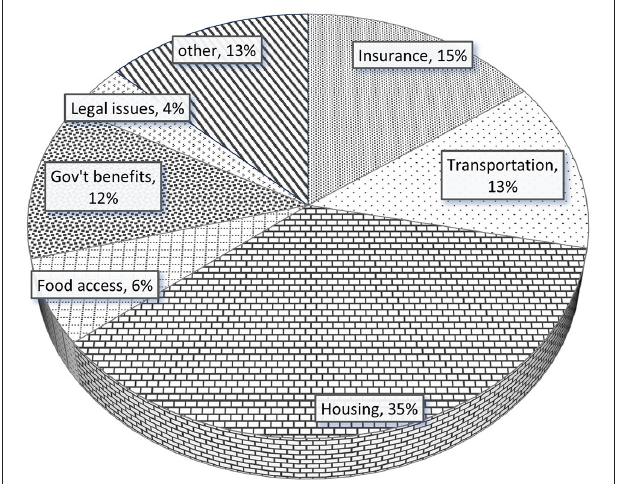
FIGURE 1 | Social determinants of health addressed during CHW